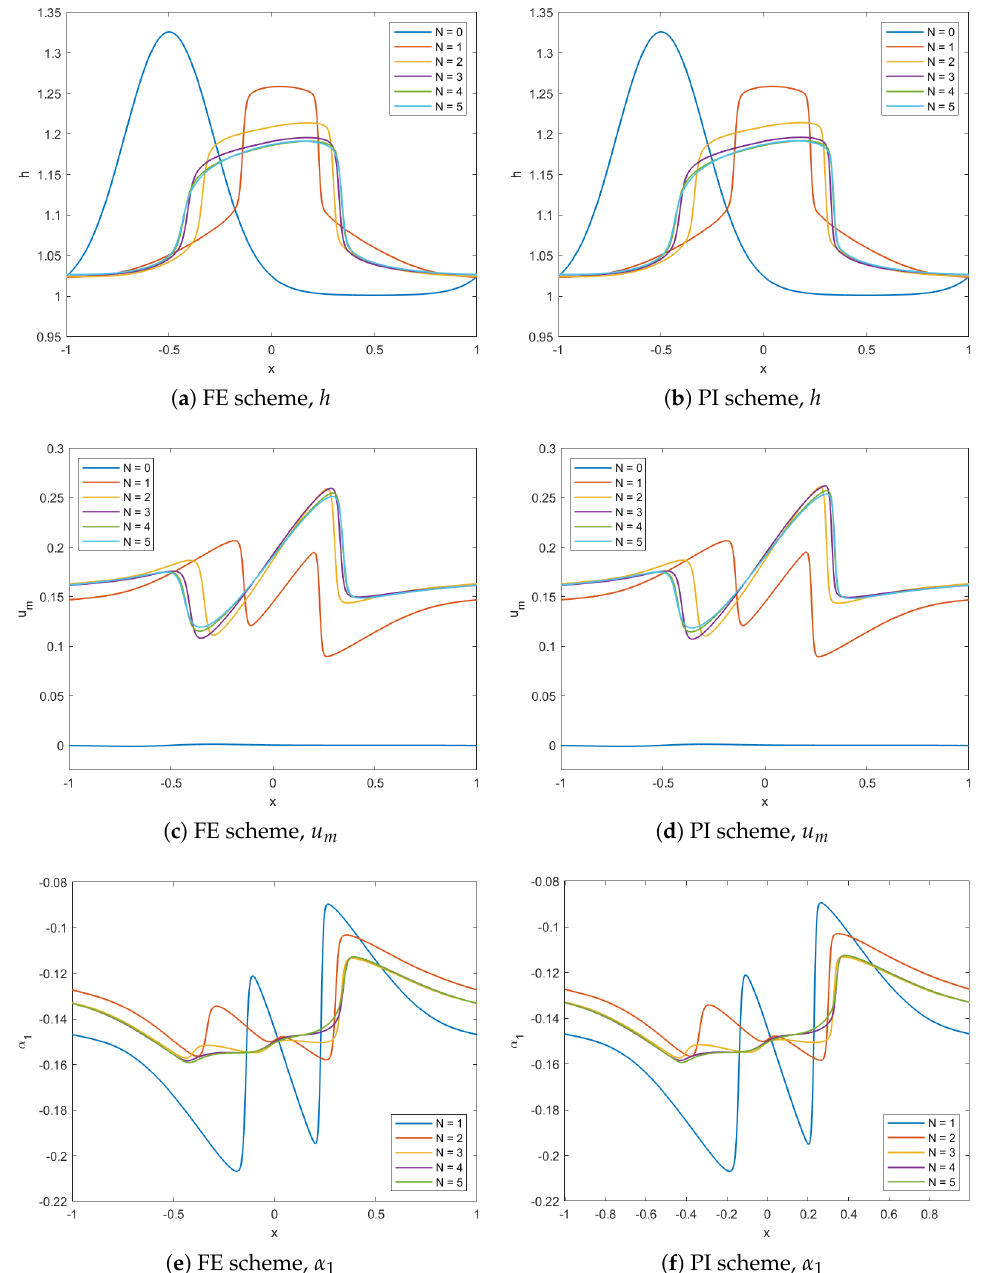
Figure 18. Periodic wave test case using FE ( a , c , e ), and PFE ( b , d , f ), for height h ( a , b ), mean velocity u m ( c , d ), and first moment α 1 ( e , f ), for varying N and constant ν = 0.1 and λ = 10 − 4 shows visibly the same accuracy for the PFE method with respect to the FE